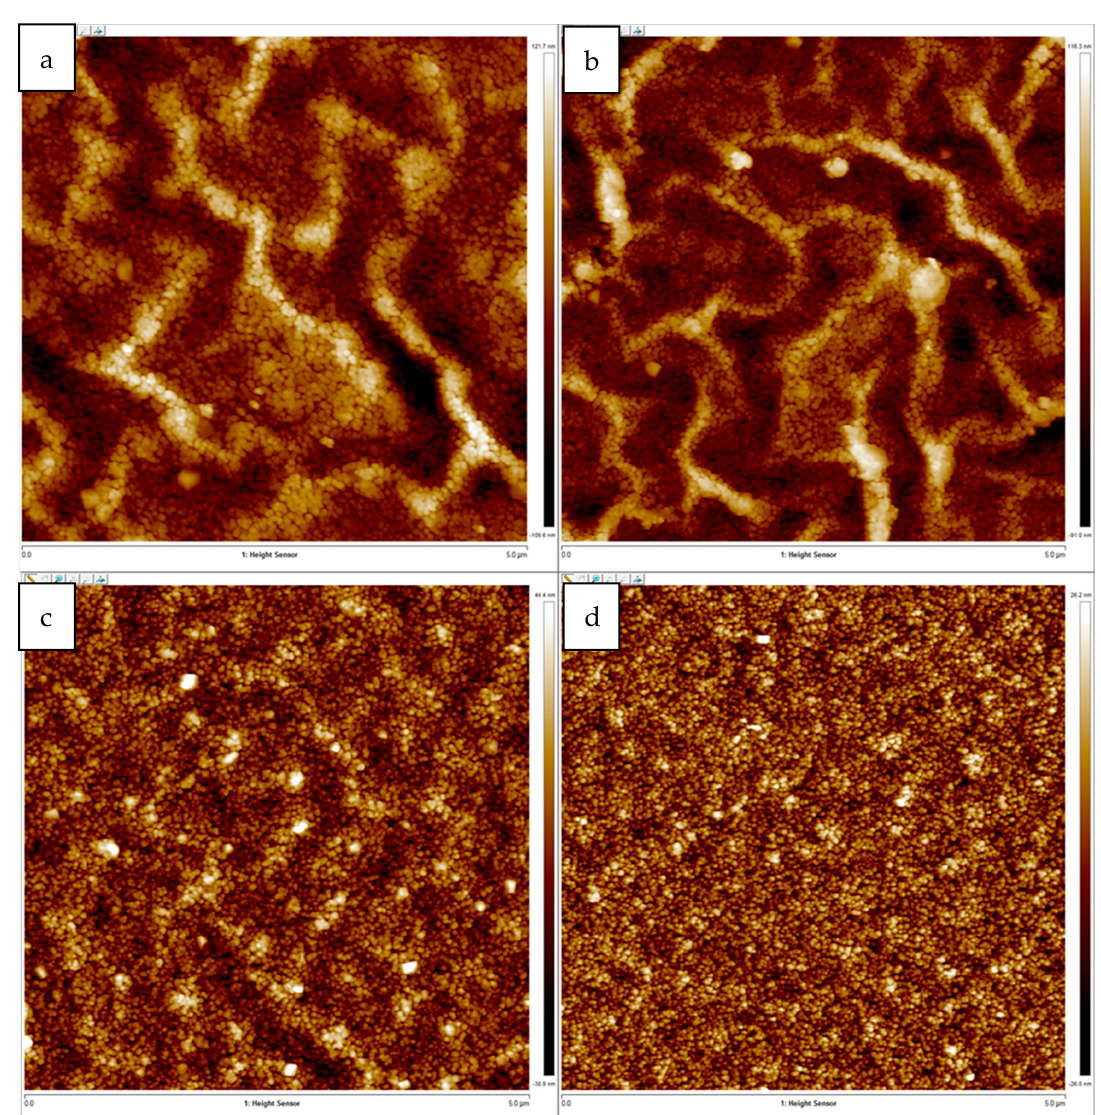
Figure 8. SEM images of ZnO film coated at ( a ) 2000 rpm, ( b ) 2500 rpm, ( c ) 3000 rpm and ( d ) 3500 Figure 8. ( a – d ) AFM images for the same films previous used for SEM rpm.